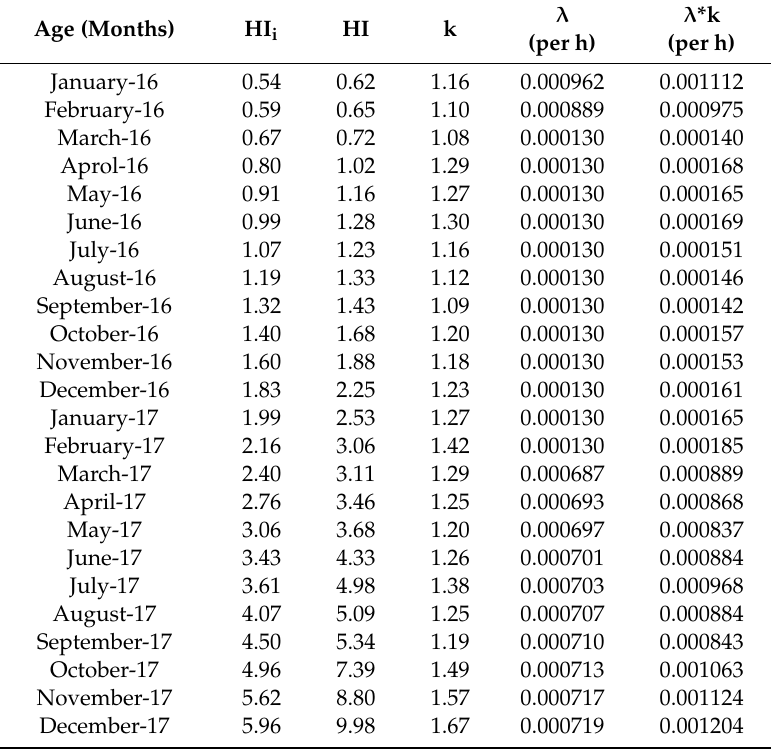
Table 10. k -factor and corrected failure rate λ *k